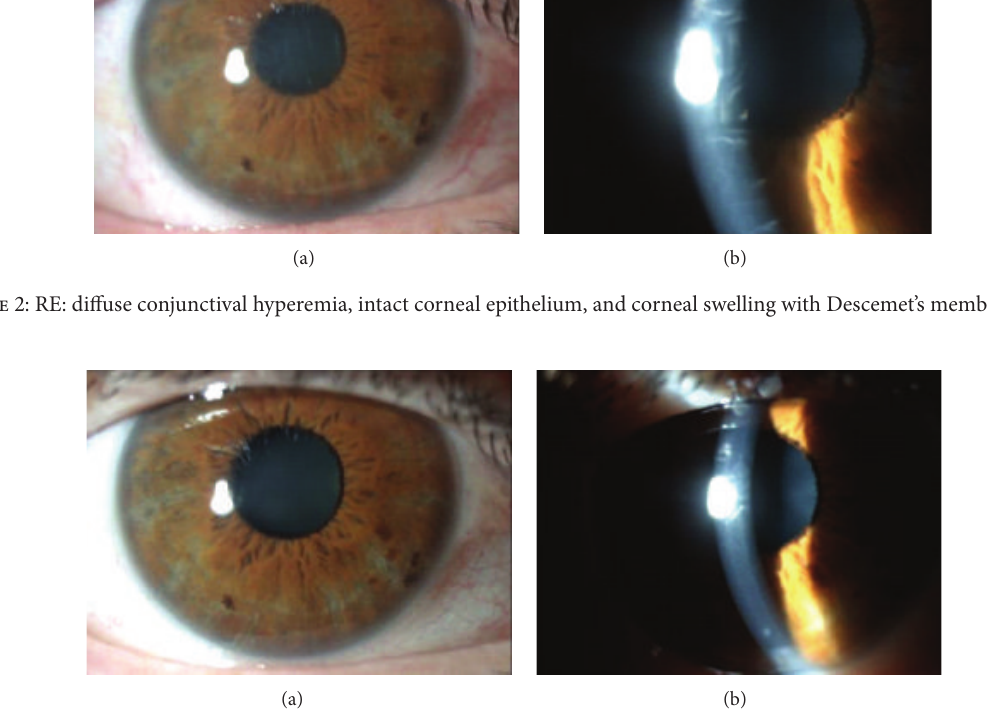
Figure 3: RE: residual corneal edema and softer Descemet’s